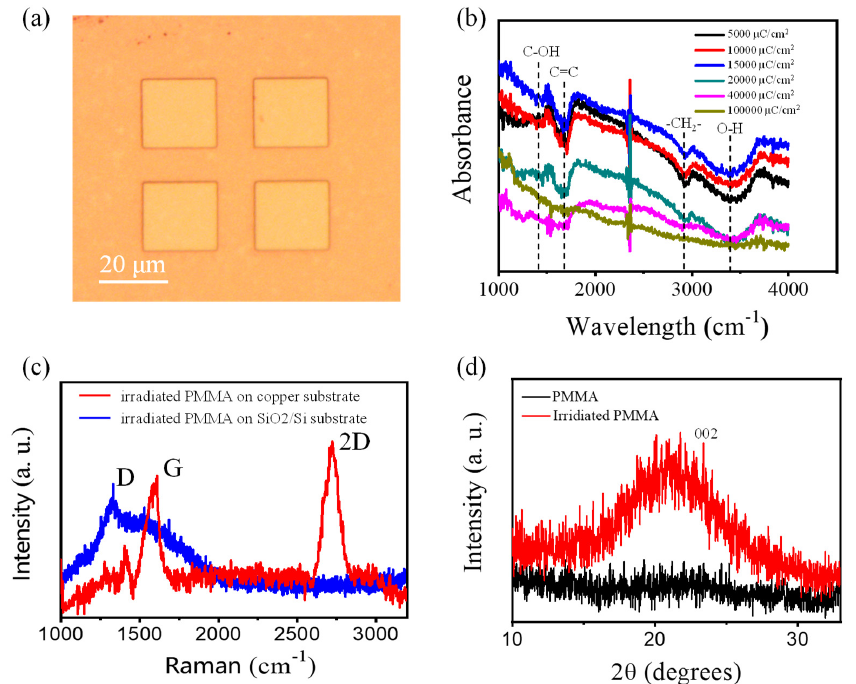
Figure 3. ( a ) Microscopy image of the e-beam-irradiated PMMA sample. ( b ) Fourier transform infrared (FTIR) absorption optical curves of PMMA film, irradiated with various exposure doses. ( c ) Raman spectra of irradiated PMMA film on copper substrate. ( d ) X-ray diffraction analysis of PMMA and irradiated PMMA film.